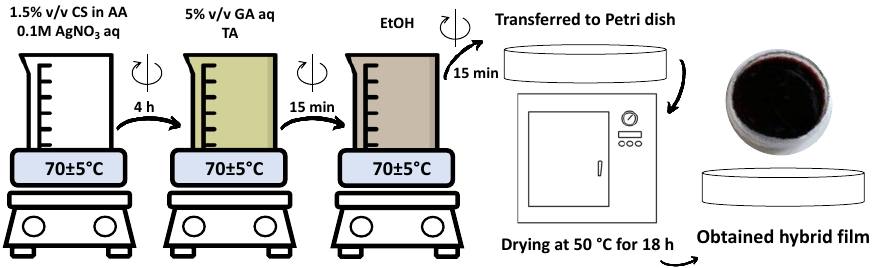
Scheme 1. Synthetic scheme representing the development of self-standing polymer films: prepara- tion of nanocolloids and further thermal treatment to obtain a solid-state nanocomposite. The labeling of the different samples is presented in Table 1. Table 1. Sample labeling of thin polymer films.